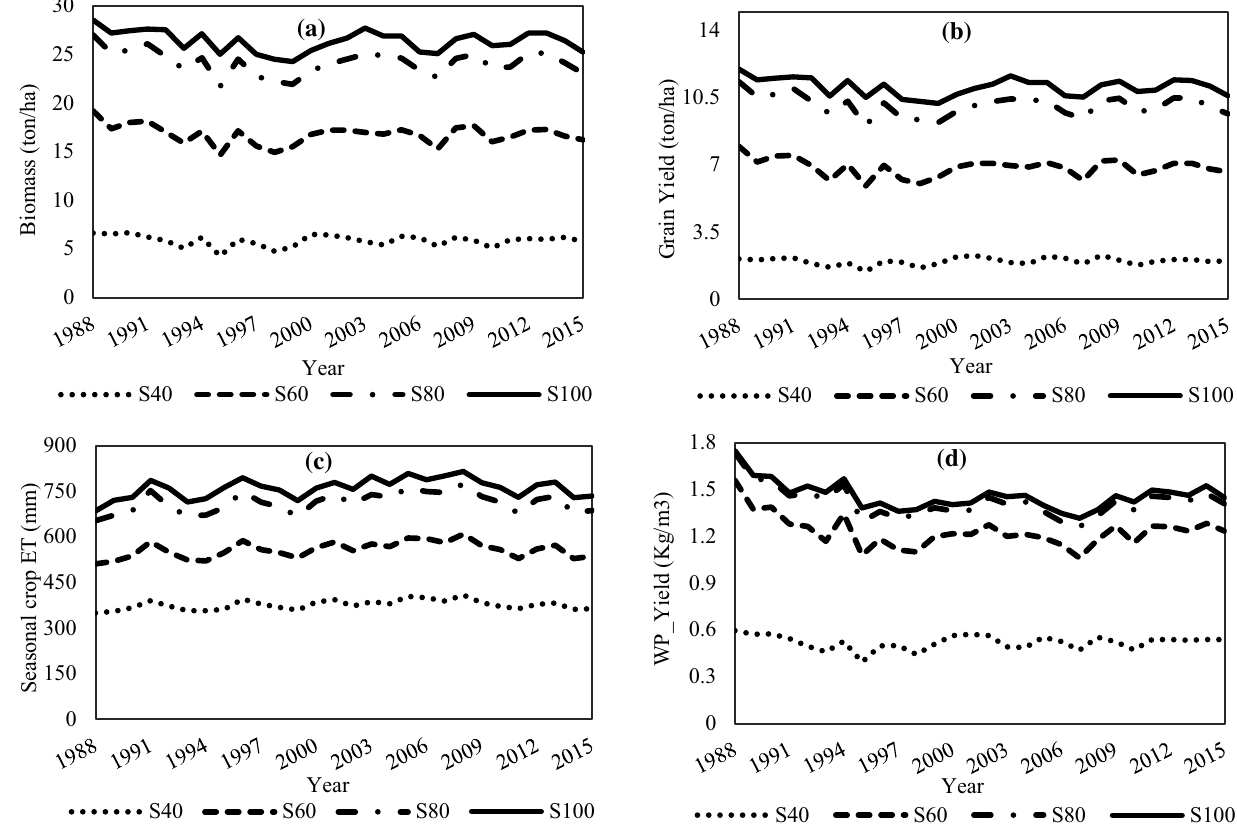
Fig. 6 Temporal changes in biomass ( a ), grain yield ( b ), seasonal crop evapotranspiration ( c ), and crop water productivity ( d ) in 1988–2015